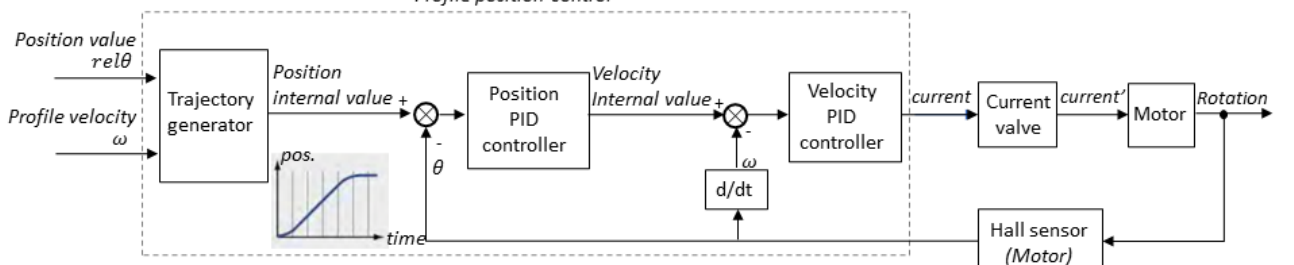
Figure 9. Block diagram of profile position